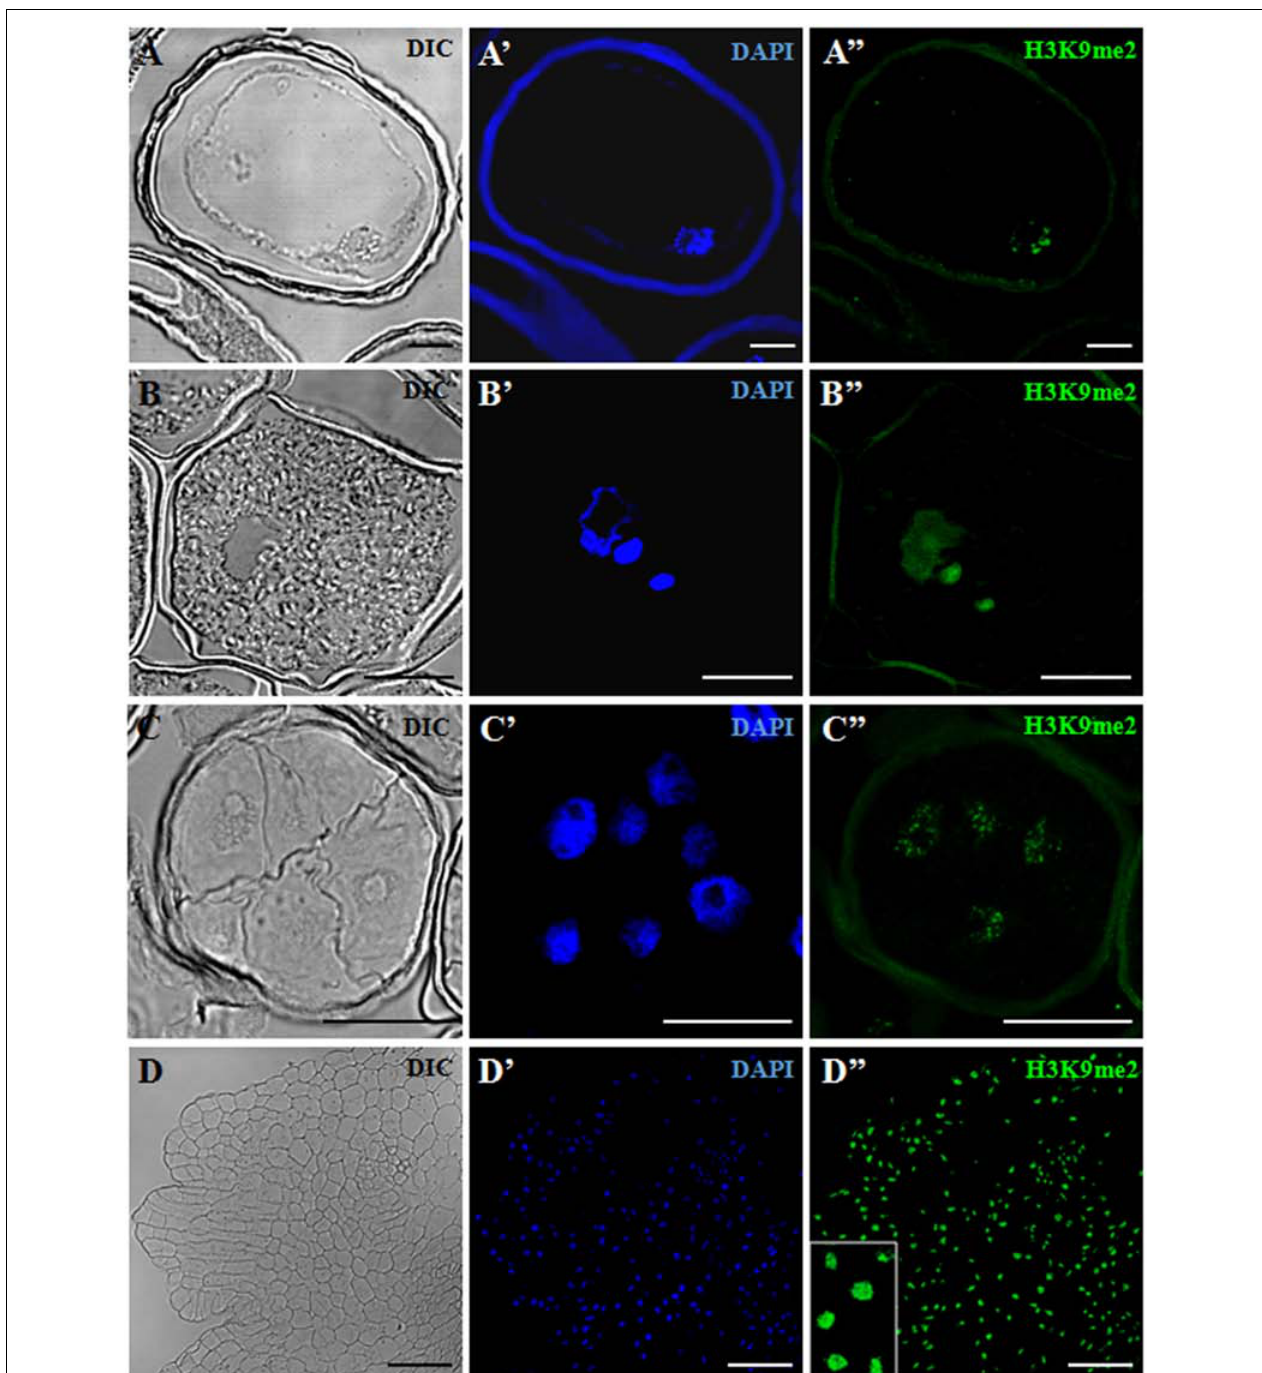
FIGURE 4 | Immunofluorescence of H3K9me2 during pollen development and microspore embryogenesis of Hordeum vulgare . Confocal laser scanning microscopy analysis of vacuolated microspores, starting point of the two developmental pathways (A–A”) , tricellular pollen, advanced stage of gametophytic development (B–B”) , proembryos, early stage after reprogramming (C–C”) and coleoptilar embryo, advanced embryogenesis stage (D–D”) . (A–D) : Nomarsky’s differential interference contrast (DIC) images showing the cellular organization of the different structures. (A’–D’) : DAPI staining of nuclei (blue). (A”–D”) : H3K9me2 immunofluorescence signal over nuclei (green). The same structures are visualized under different microscopy modes in (A–A”) , (B–B”) , (C–C”) and (D–D”) . Inset shows a detail of (D”) at higher magnification. The exine showed unspecific autofluorescence in some images (A’,A”,B”,C”) . Bars represent: (A–A”) , (B–B”) : 10 µ m, (C–C”) : 20 µ m, (D–D”) : 75 µ